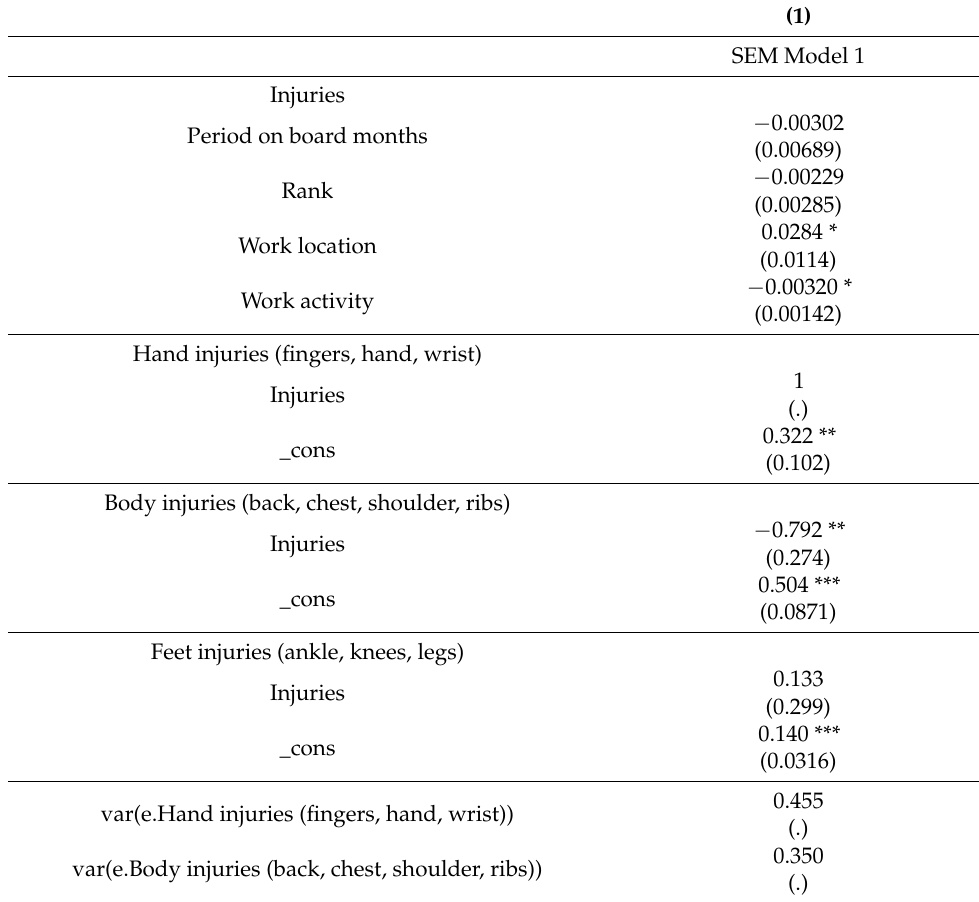
Table 4. Detailed results of SEM 1—first model of structural equation modeling.